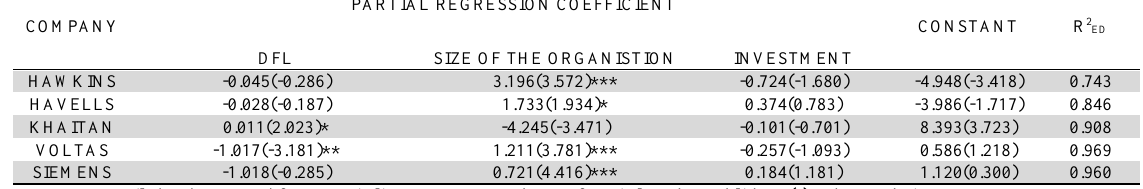
Analysis of Multiple Regression of Avg. Cash Holding on DFL, Size of Org. and Investment of the Selected Companies of Consumer Durable Sectors.